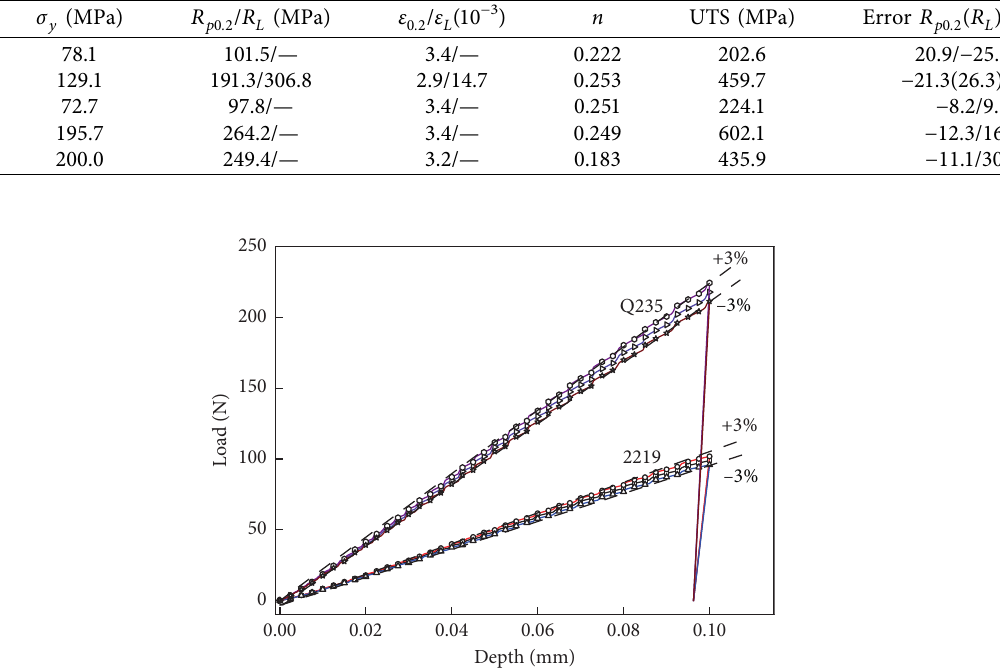
Figure 8: Indentation curves with error bands.